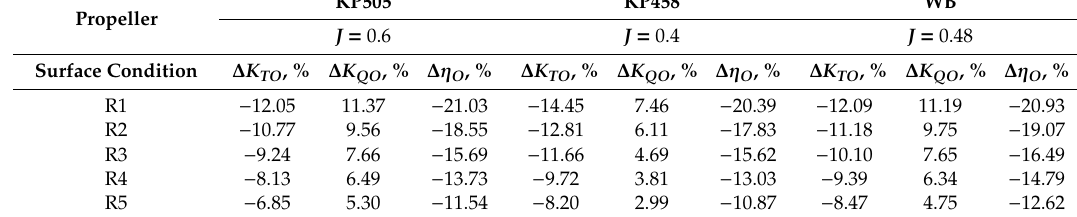
Figure 10. The impact of hard fouling (R1) on KP505 ( upper ), KP458 ( middle ) and WB ( low er) performance in OWT.